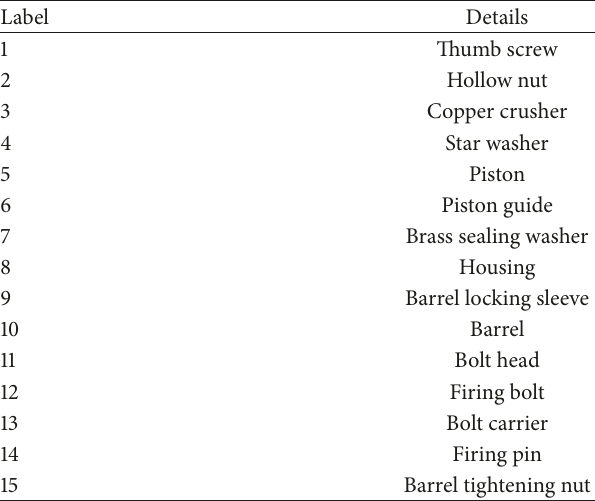
Figure 14: Refinement where max pressure occurs. Table 1: Detail of labels used in Figure 11.